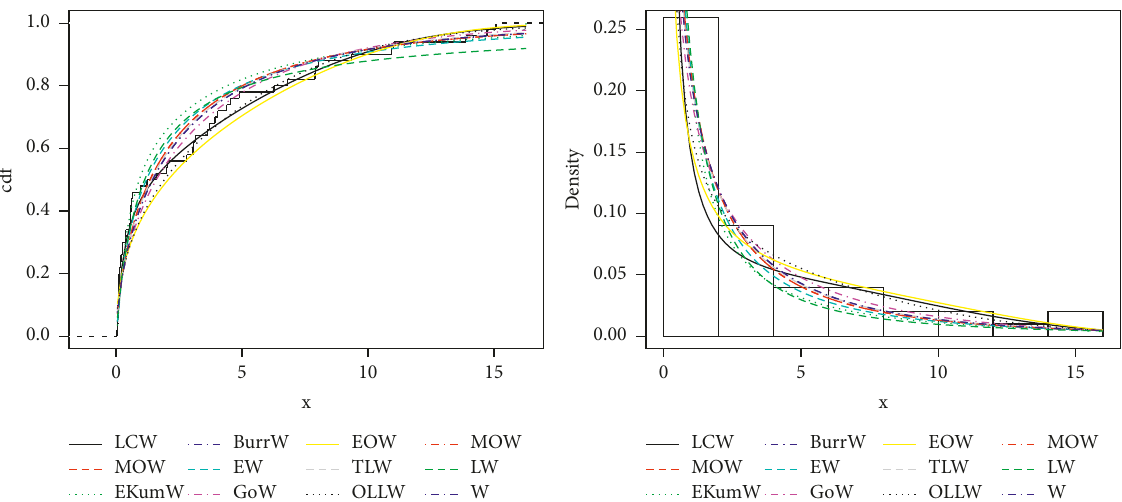
Figure 7: The comparative cdf and pdf of LCW and other models using failure time